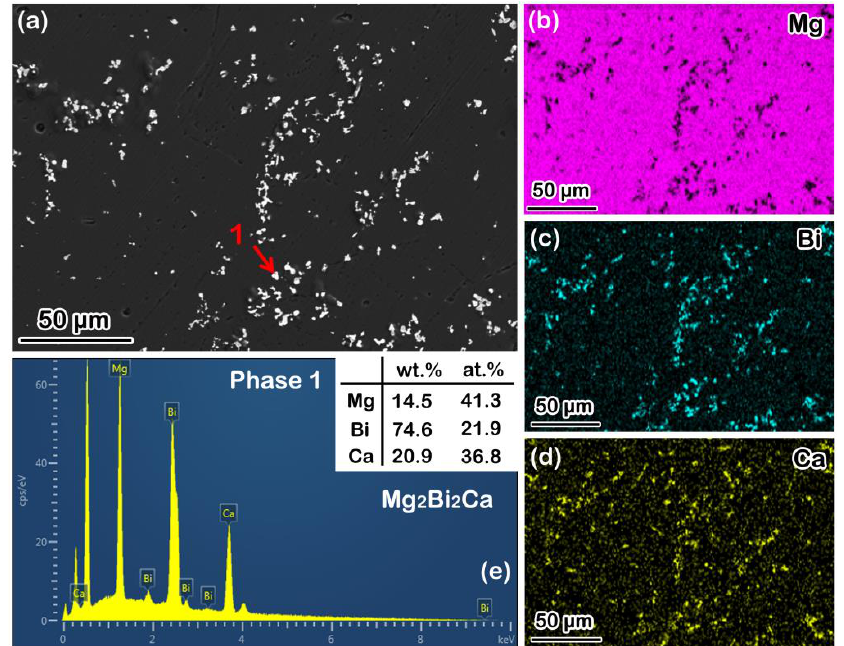
Figure 1. ( a ) SEM image; ( b – d ) SEM-EDS mapping scanning results from ( a ); ( e ) SEM-EDS point scanning result from phase 1 marked by red arrow in ( a ).